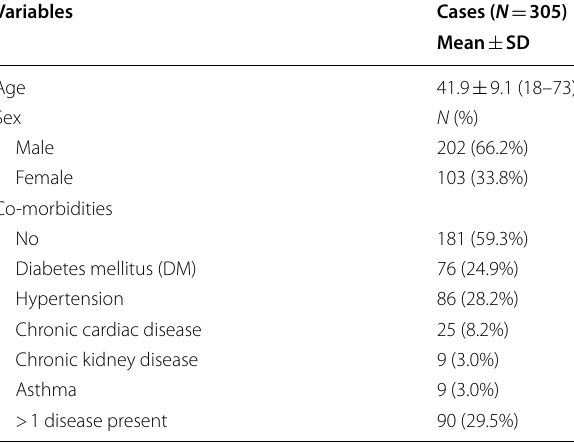
Table 1 General characteristics of the studied cases